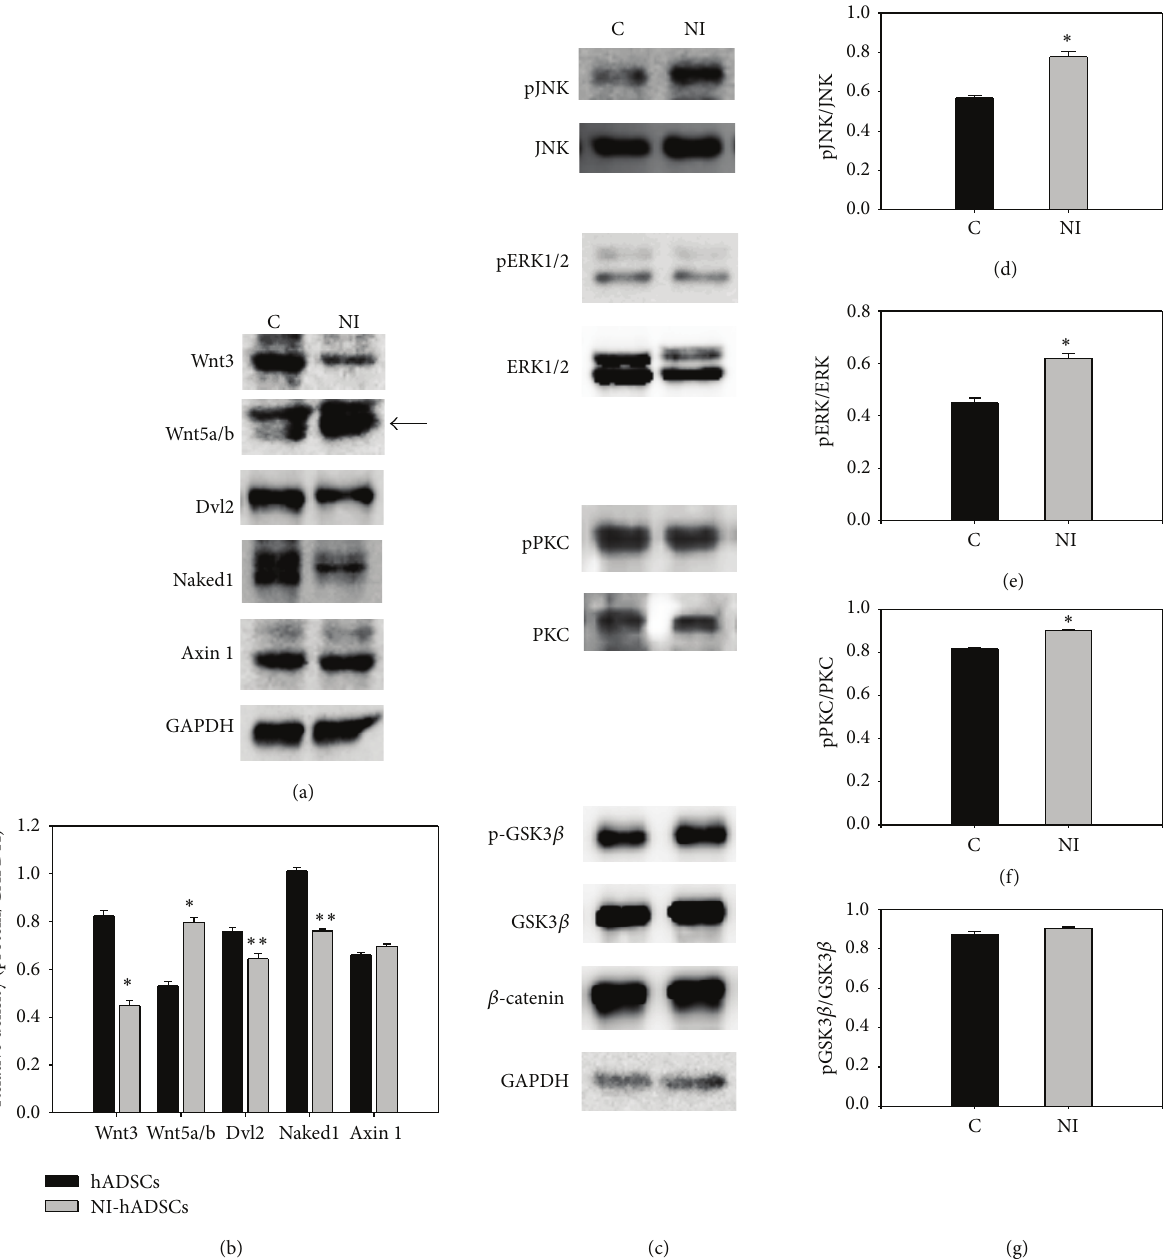
Figure 3: Expression of Wnt signal-related proteins. Western blot analysis demonstrated the Wnt signal in NI-hADSCs (a and b). The expression of Wnt3 is decreased in NI-hADSCs, but interestingly Wnt5a/b expression is upregulated after neural differentiation compared with primary hADSCs. Dvl2 protein is very slightly changed between primary hADSCs and NI-hADSCs. However, the expression of Naked1 is downregulated in NI-hADSCs compared with primary hADSCs. (c–g) Western blot analysis for Wnt signal-related proteins. The expression of phosphor-JNK, which is one of the downstream noncanonical pathways, is upregulated in NI-hADSCs compared with primary hADSCs. Also, ERK1/2 protein level is decreased after neural differentiation. (d–g) Quantified results of protein expression. The western blot was repeated three times independently of different cells and the representative data are shown. The intensity of each gene was normalized to GAPDH or 𝛽 -catenin. ∗ 𝑃 < 0.05 compared with the primary